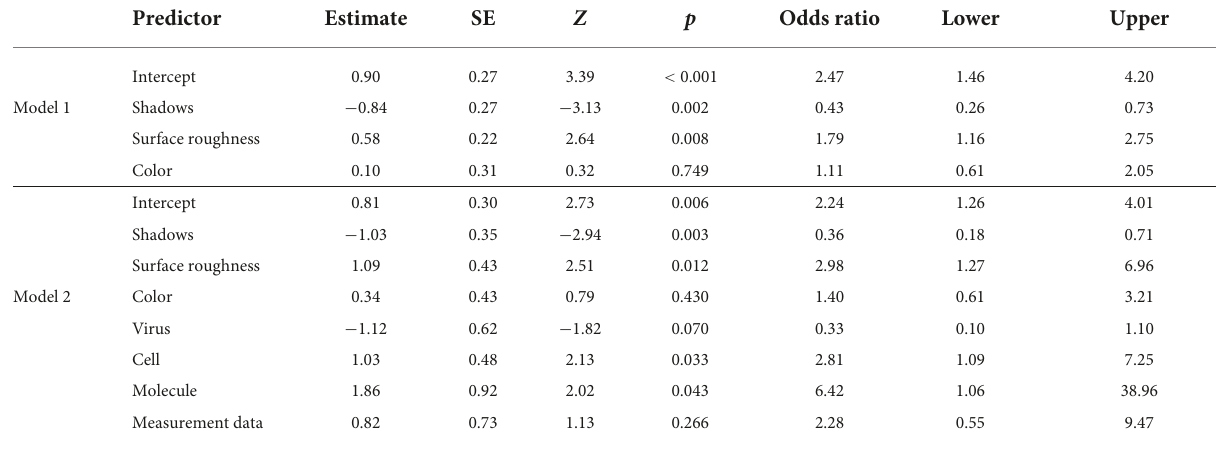
TABLE 3 Binary logistic regression analysis of participants’ image